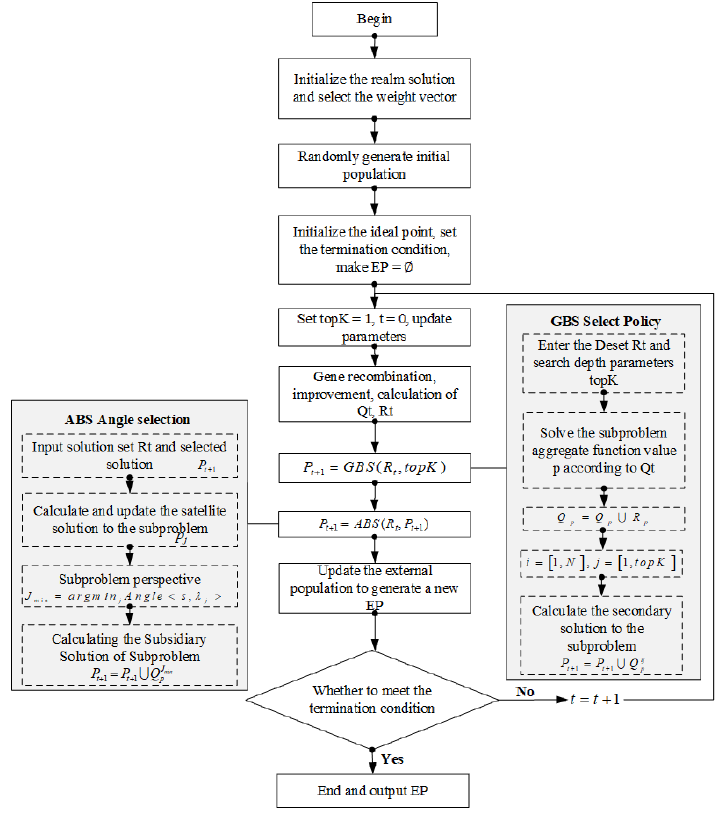
Figure 9. The flow chart of the MOEA/D-GABS algorithm.